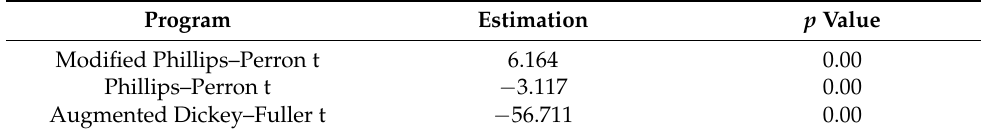
Table 6. Co-integration